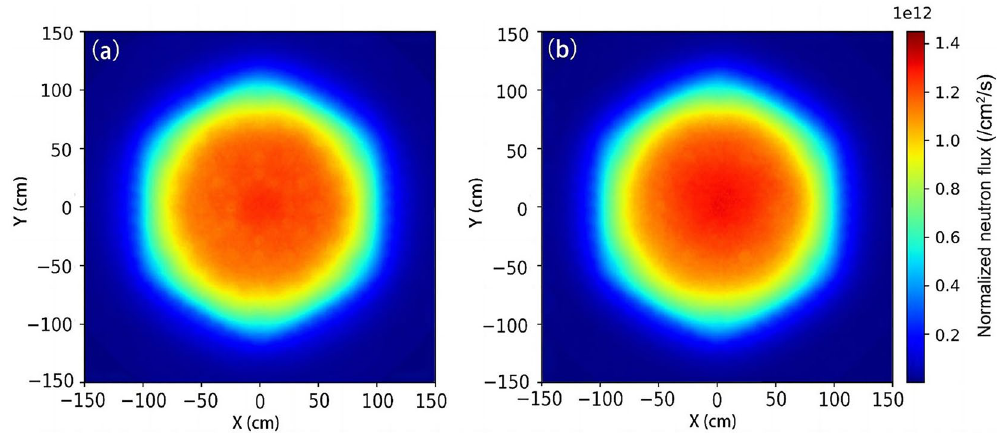
Figure 3. The distribution of neutron flux with MAs ( a ), and without MAs ( b ) at the beginning of the core cycle.